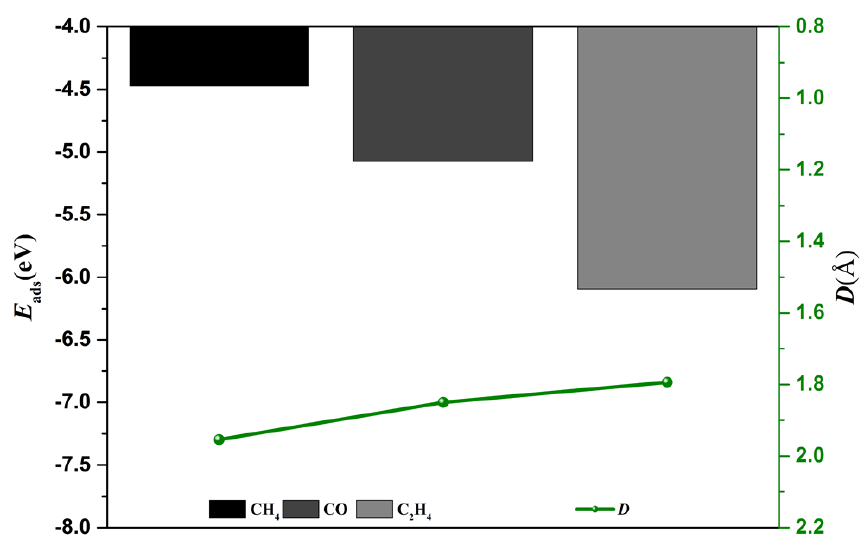
Figure 4. The adsorption energy and adsorption distance of CH 4 , CO, and C 2 H 4 on the Cr-InN monolayer.